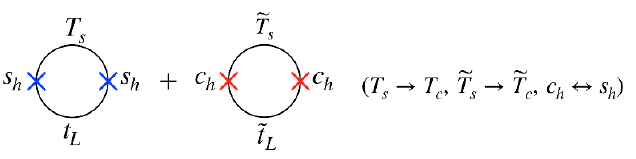
Figure 5 . Naturalness condition by mirror Z 2 symmetry is realized if the mirror parity between the visible sector and hidden sector is assigned. Quadratic divergence is cancelled as V ( h ) (cid:24) (cid:3) 2 (cid:1) ( s 2